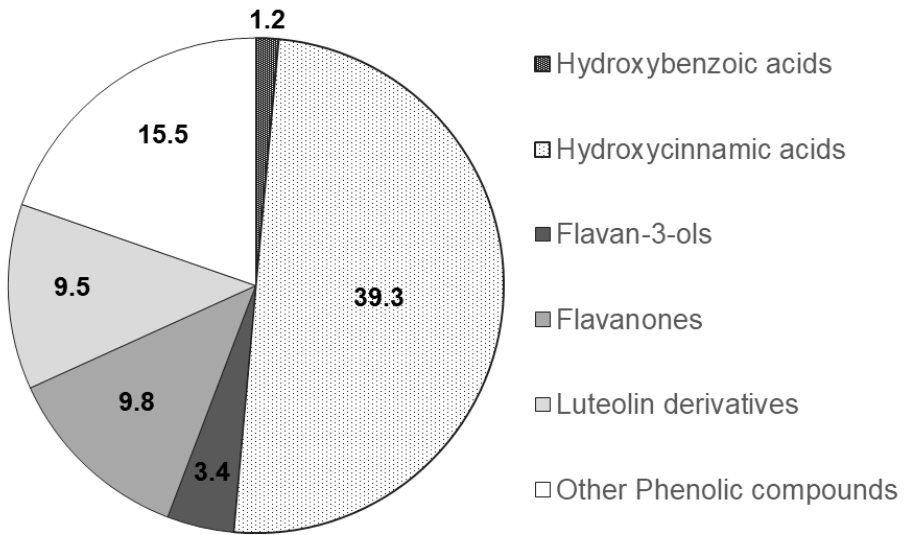
Figure 2. Relative chromatographic area distribution of the main phenolic functional groups detected in the Mentha spicata aqueous extract.